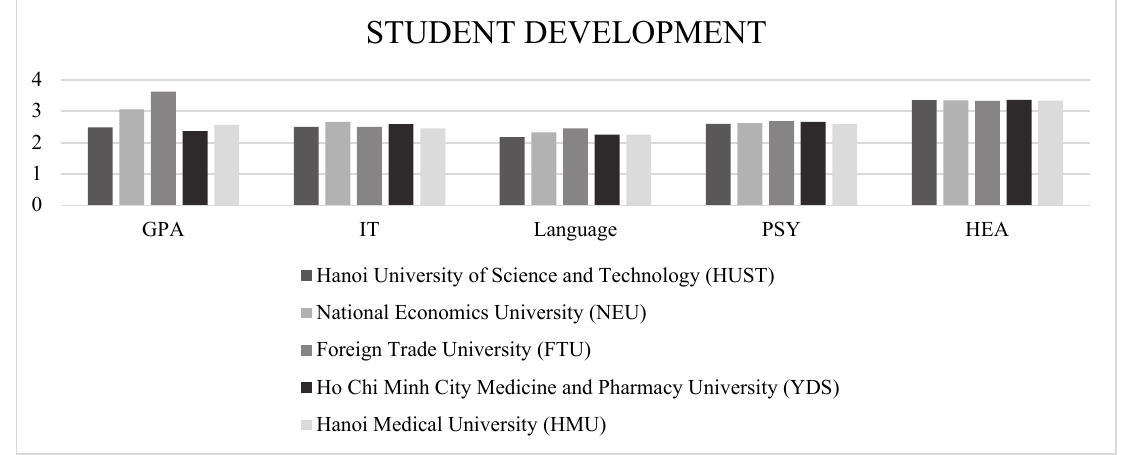
Fig. 3. Dependent variables of 5